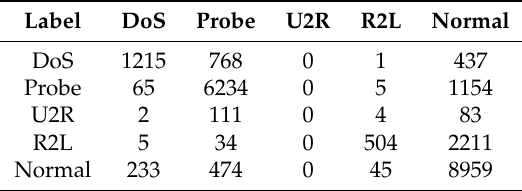
Table 10. Confusion matrix of CNN.